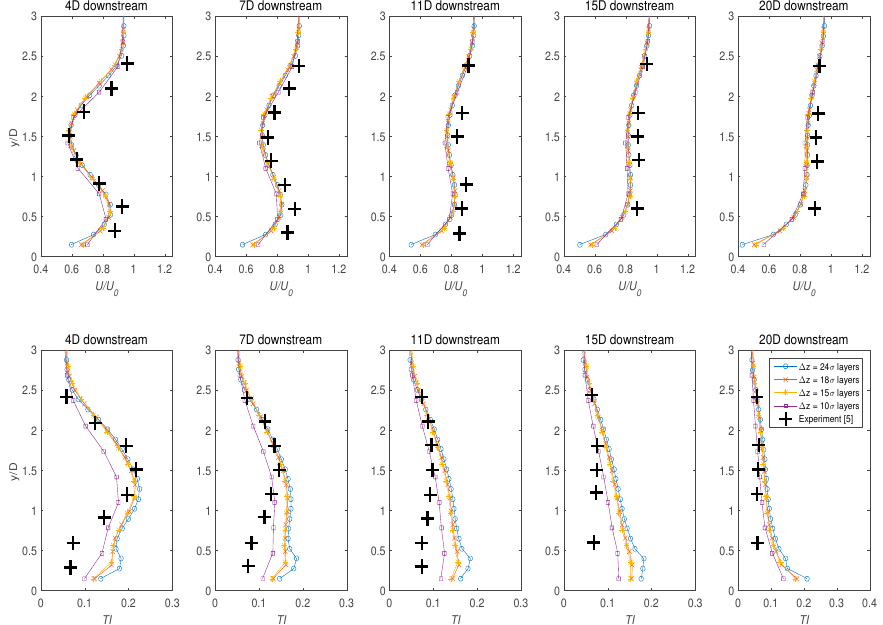
Figure 9. The influence of the vertical resolution ∆ z on the flow at increasing distances downstream of the turbine. The value of ∆ z was varied, while the size of the structured grid ( ∆ x & ∆ y ) was set to 2 m.